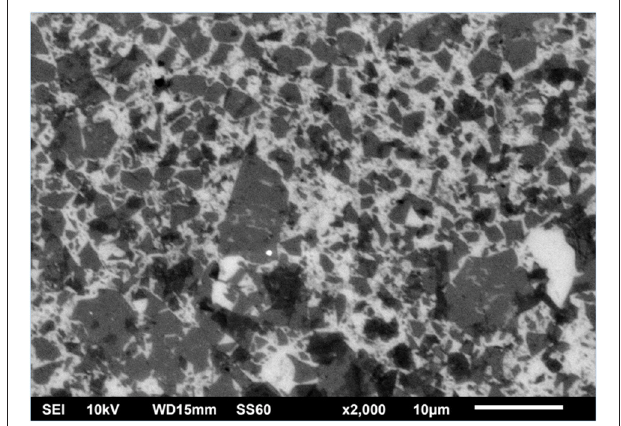
FIGURE 2 | SEM micrograph of the GO flakes onto the Si